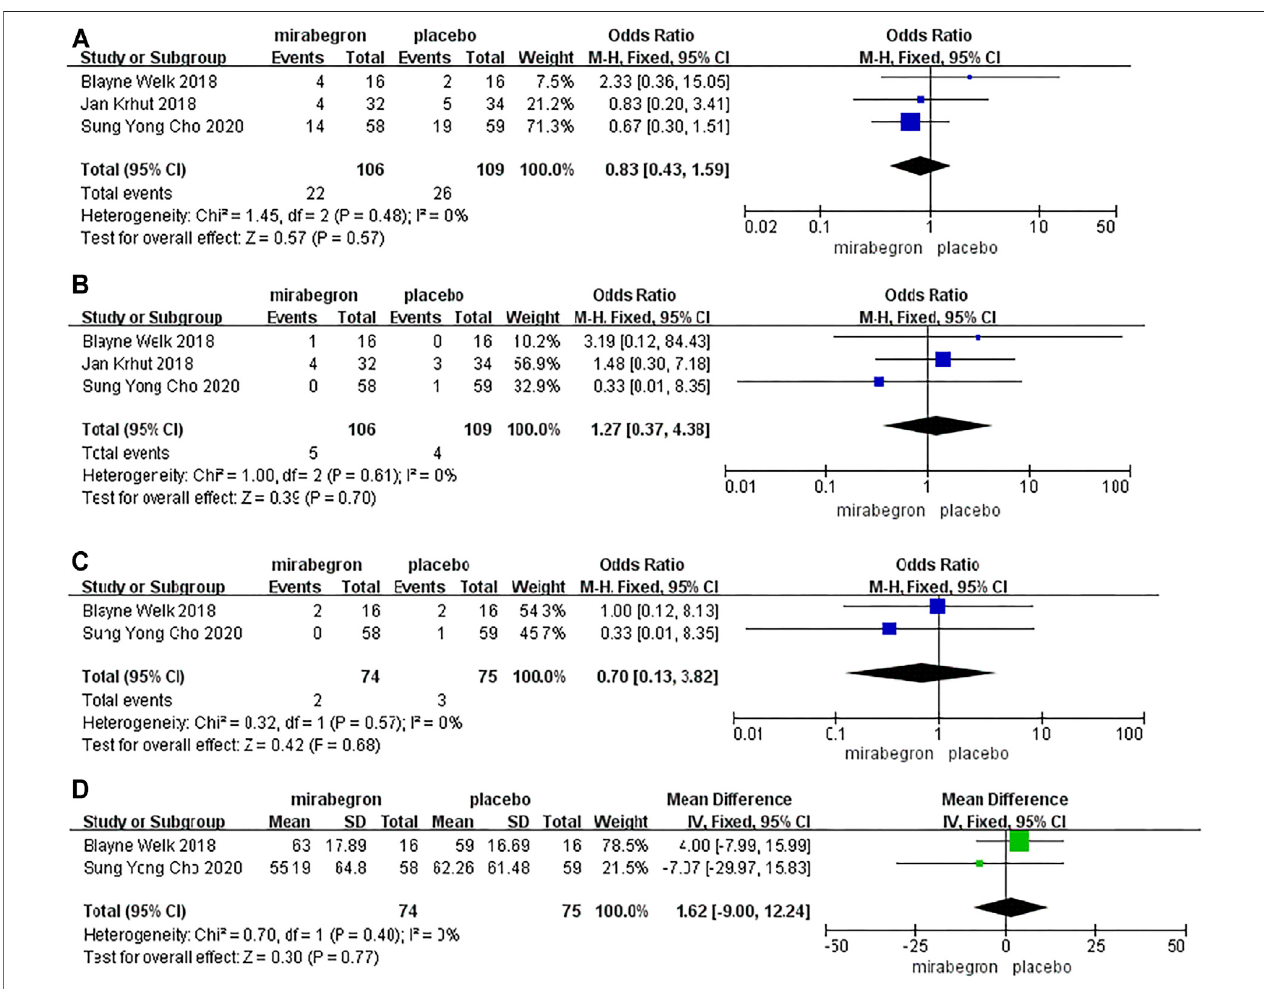
FIGURE 3 | Forest plots showing changes in (A) adverse events, (B) heart rate, (C) blood pressure, and (D) post-voiding residual volume.